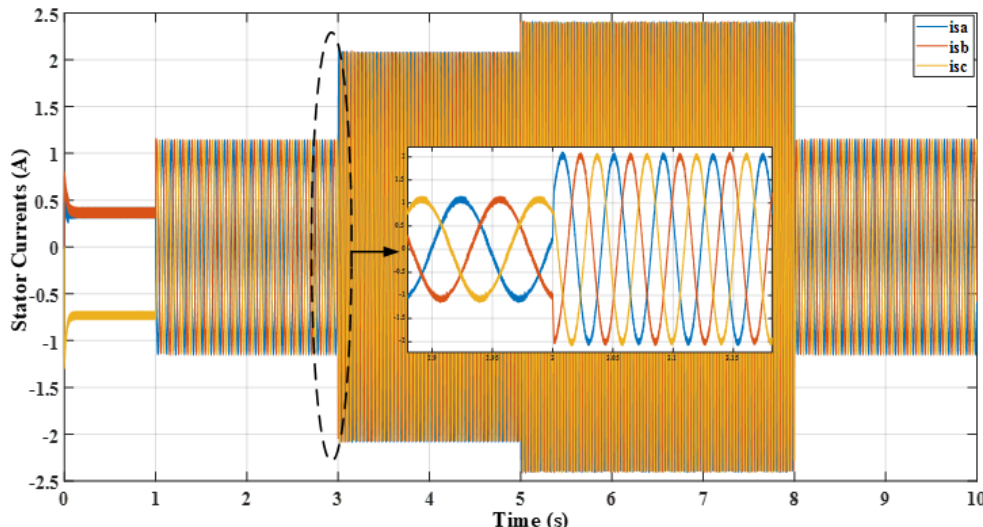
Figure 13. The DTRFC with successive steps of torque reference for current response.